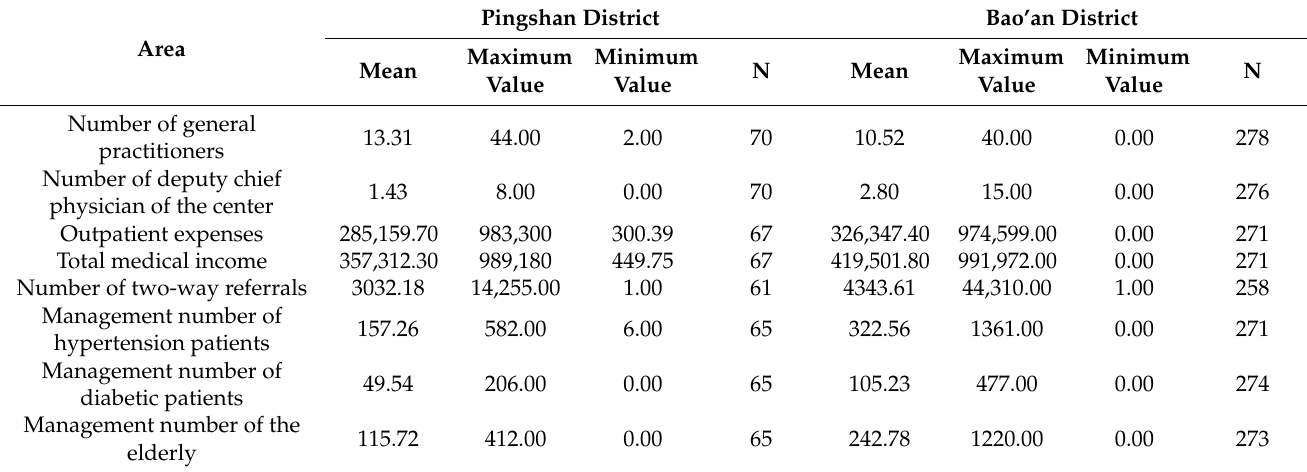
Table 6. Basic information of primary care Service centers in different districts.